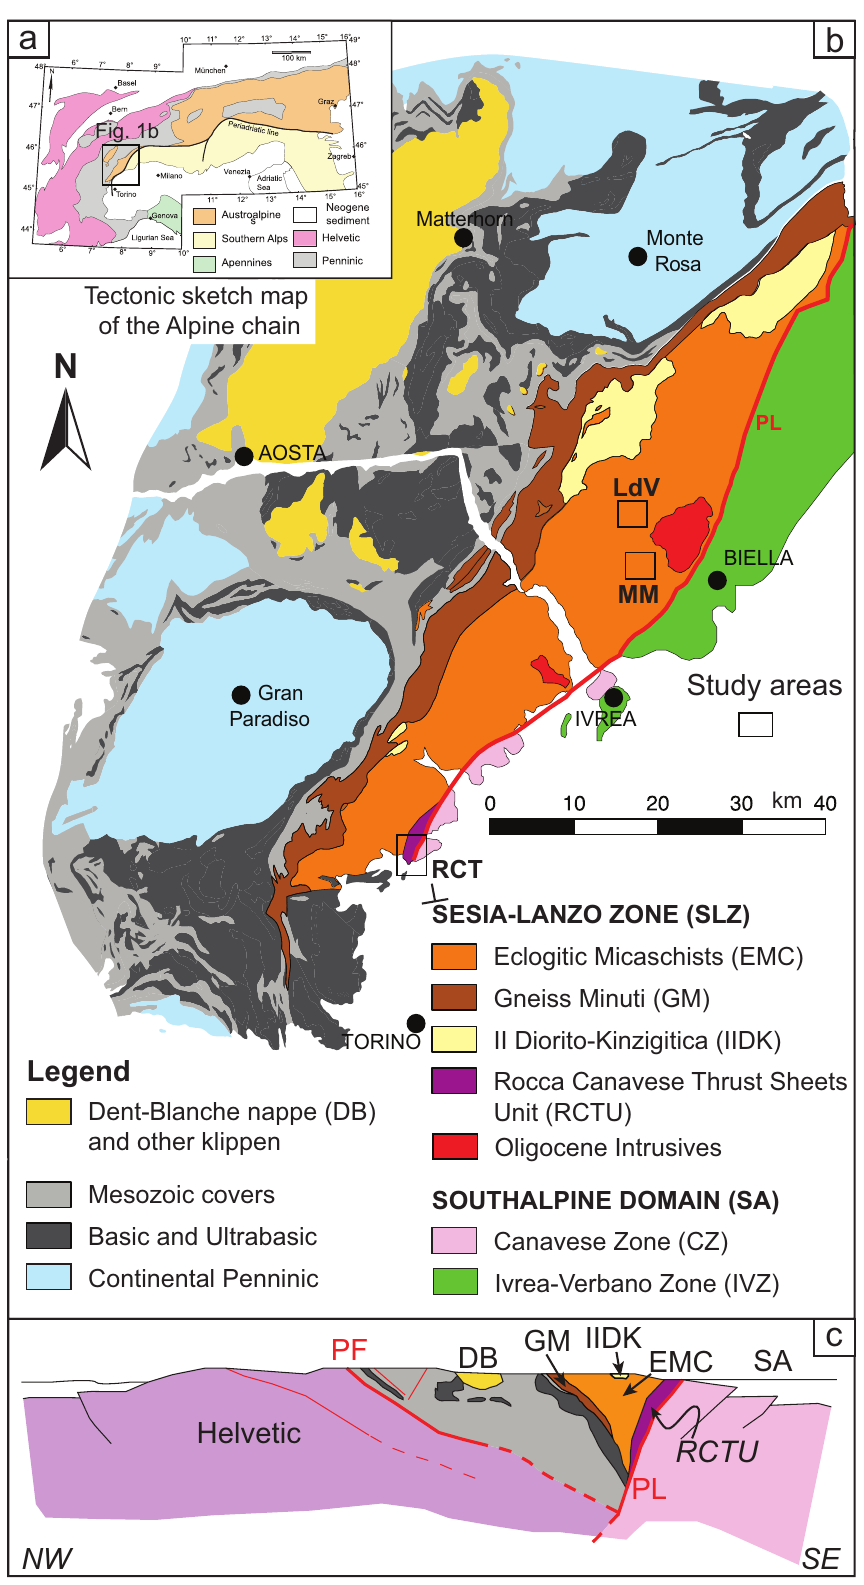
Figure 1. ( a ) Simplified sketch map of the tectonic domains of the Alps; ( b ) Sketch map of the Sesia- Lanzo Zone (modified after [19,40,55,74,78,82,83]) with the location of sampling areas: Lago della Vecchia (LdV), Monte Mucrone (MM), and Rocca Canavese (RCT); ( c ) simplified geological cross-section through the Western Alps modified after [84]. PL = Periadriatic lineament; PF = Penninic